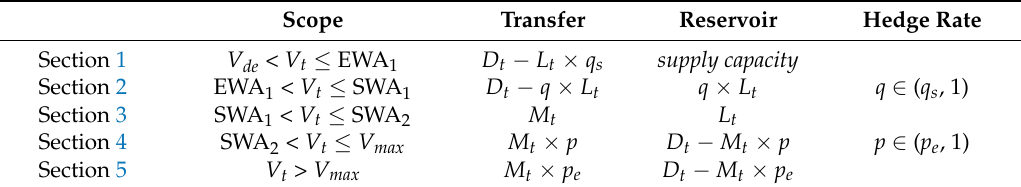
Table 1. Supply process of